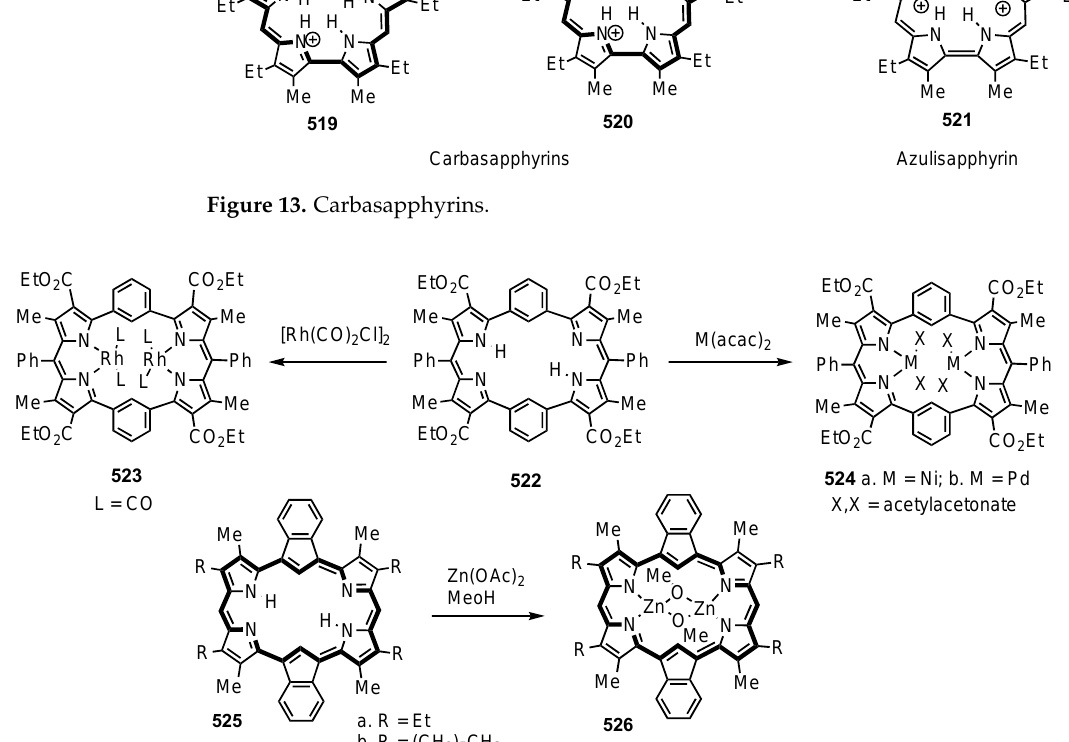
Scheme 79. Coordination complexes of dibenzi- and dicarba-amethyrins.